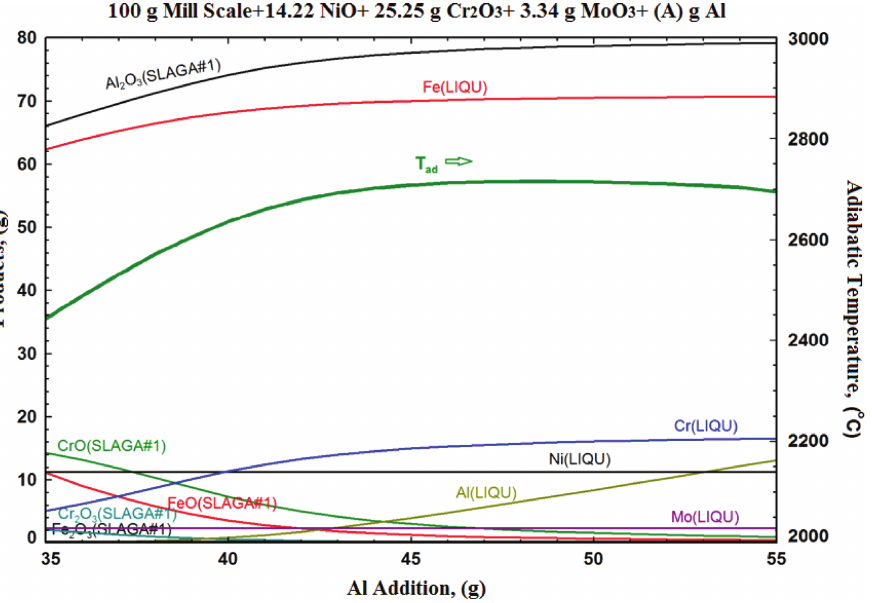
Figure 3: The change of adiabatic temperature with the increase in Al reductant amount on mill scale - NiO - Cr 2 O 3 - MoO 3 - Al reactant